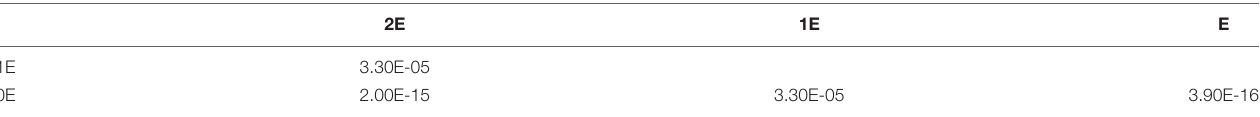
TABLE 4 | Pairwise comparisons using Wilcoxon rank sum test for the variable group production ( p